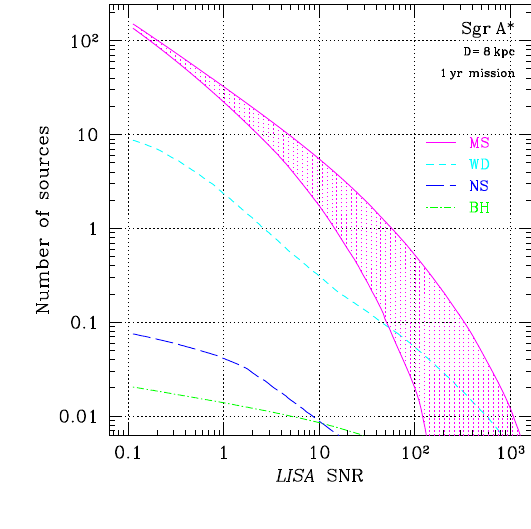
Fig. 59 Number of sources at the GC depending on their compactness. This figure displays the number of MSSs, WDs, NSs and stellar-mass black holes as a function of the SNR in LISA for a one year mission and assuming a distance of 8 kpc. Image reproduced with permission from